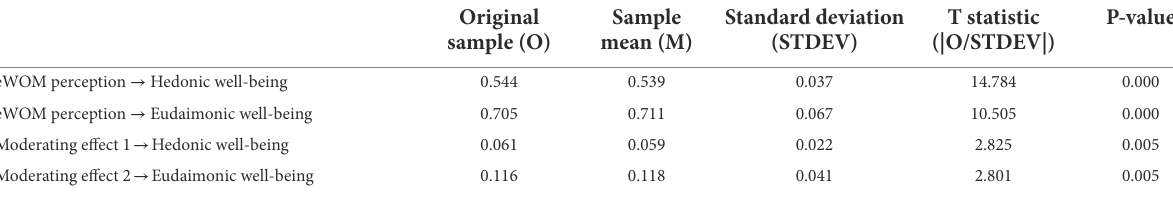
TABLE 10 Study 2: Path coefficients under moderating effect (historical